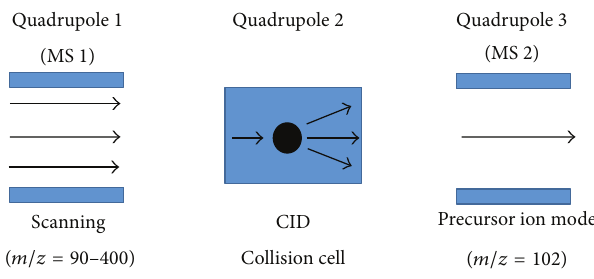
Figure 2: Precursor ion experiment using Agilent 6490 Triple Quadrupole LC/MS system.